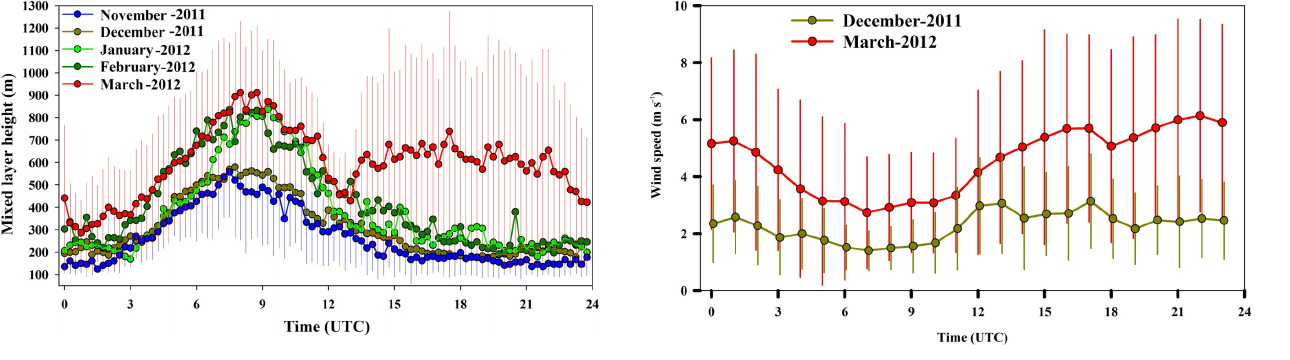
Figure 5. Monthly averaged mixed layer height determined from 15min averaged S/N profiles, measured with RWP. For the sake of clarity, variability is only shown for November and March months. Table 1. RWP data set used for studying the mixed layer height evolution.